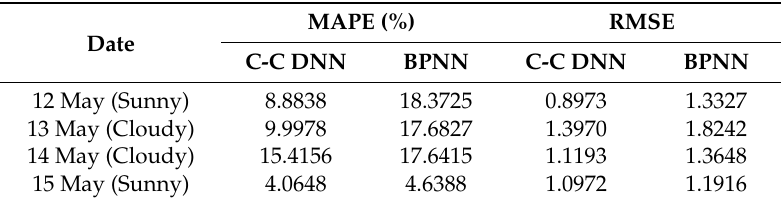
Table 1. Prediction accuracy of different